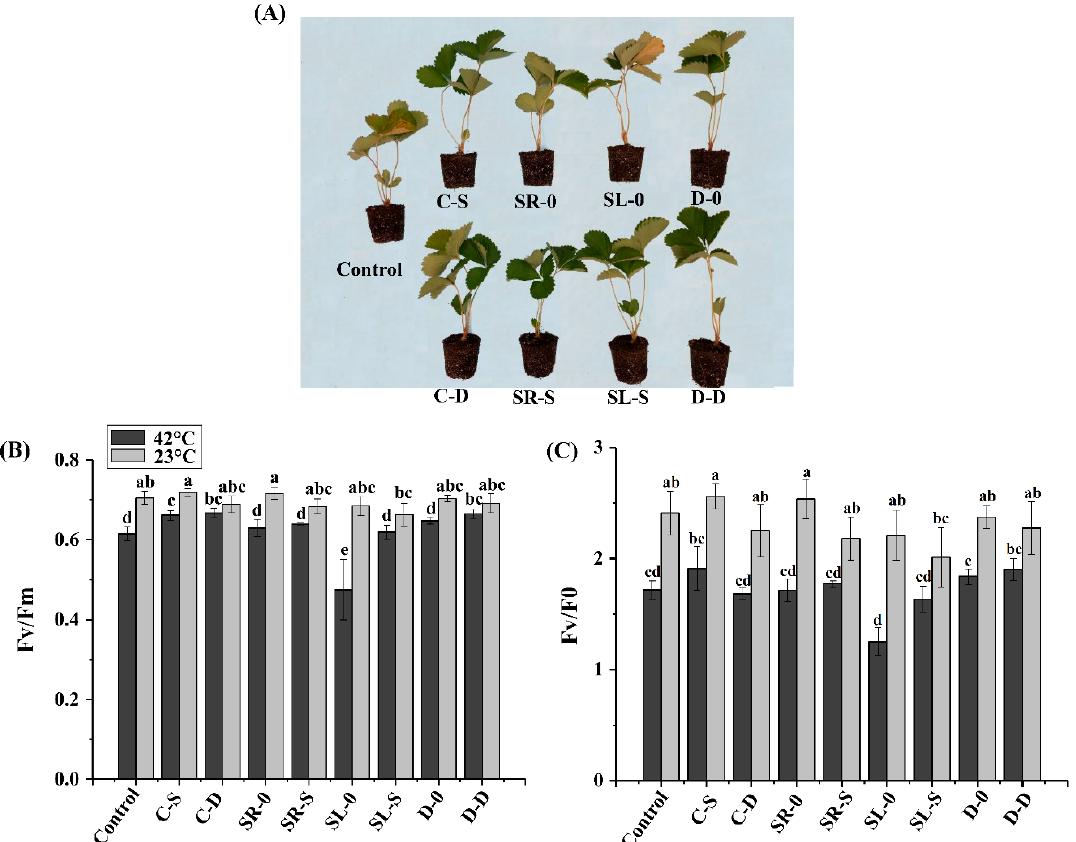
Figure 3. The morphological characteristics of strawberry subjected to a high temperature for one week ( A ), and the chlorophyll fluorescence parameters Fv/Fm ( B ) and Fv/F0 ( C ) as affected by a high temperature. Lowercase letters indicate significant differences calculated by Duncan’s multiple range test at p ≤ 0.05. Vertical bars indicate the standard error ( n = 3). The letters before the hyphen indicate Si being applied before the cutting propagation, while the letters after the hyphen represent Si being supplied after the cutting propagation. C, control; SR, spraying the runners; SL, spraying the leaves; D, drenching the roots; 0, spraying distilled water; S, spraying the leaves.